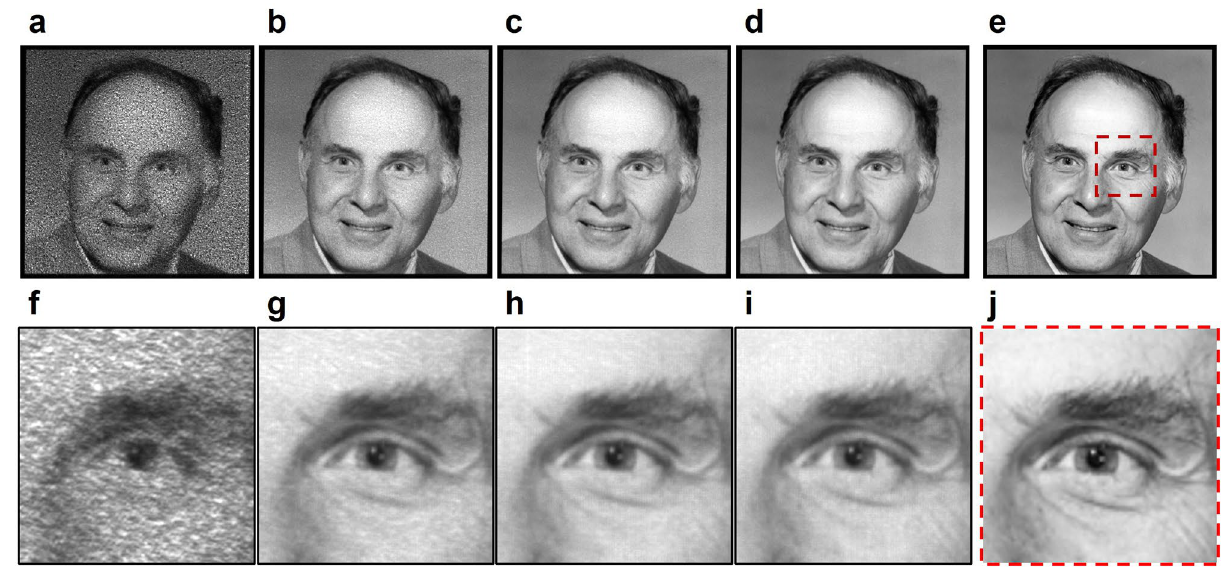
Figure 5. Experimentally reconstructed pattern “Arthur” (Reused with the permission of Nokia Corporation and AT&T Archives). ( a – d ) Line-wise reconstructed patterns (340 × 340 pixels) with different line integration times: ( a) 1 T T ; ( b ) 5 T T ; ( c ) 10 T T ; ( d ) 20 T T . ( f – i ) Zoomed excerpt of the corresponding image above. ( e ) Digital target pattern (340 × 340 pixels) and ( j ) zoomed excerpt (85 × 85 pixels). Coherent artifacts are effectively eliminated by the hologram motion. Nevertheless, the transition between different holograms displayed on an AOD introduces crosstalk noise. The visibility of the noise reduces rapidly with an increasing detector integration time